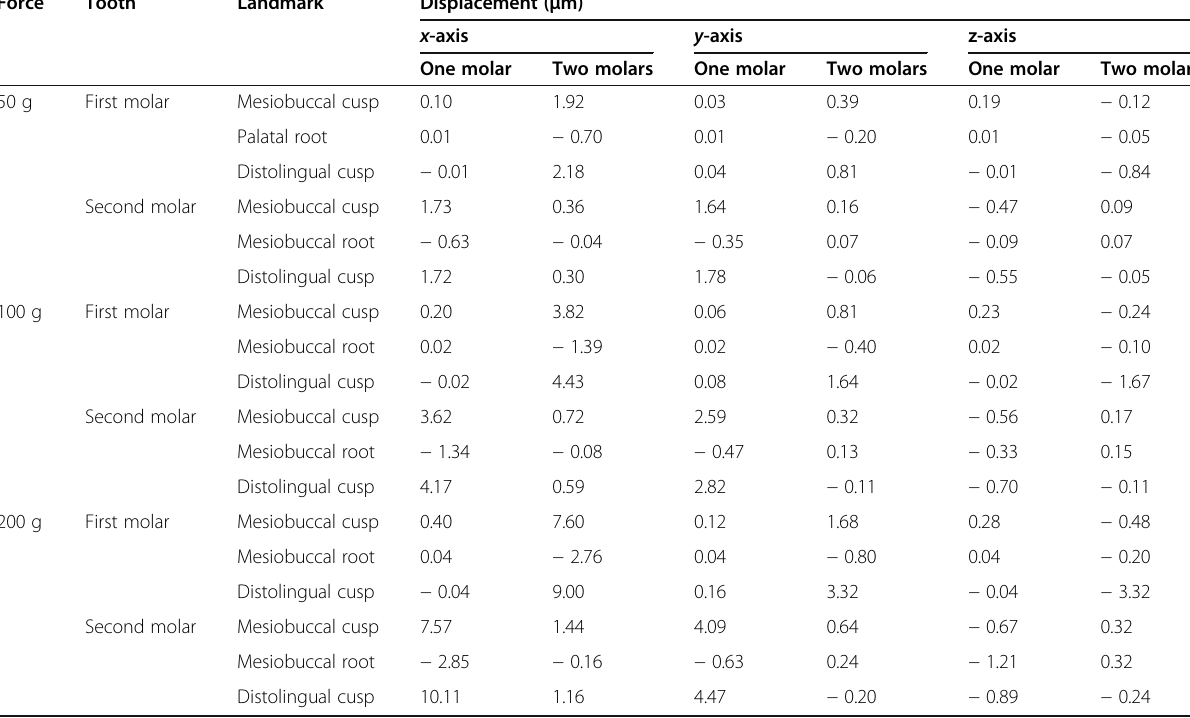
Table 4 The initial displacement of the first and second molar ( μ m) Force Tooth